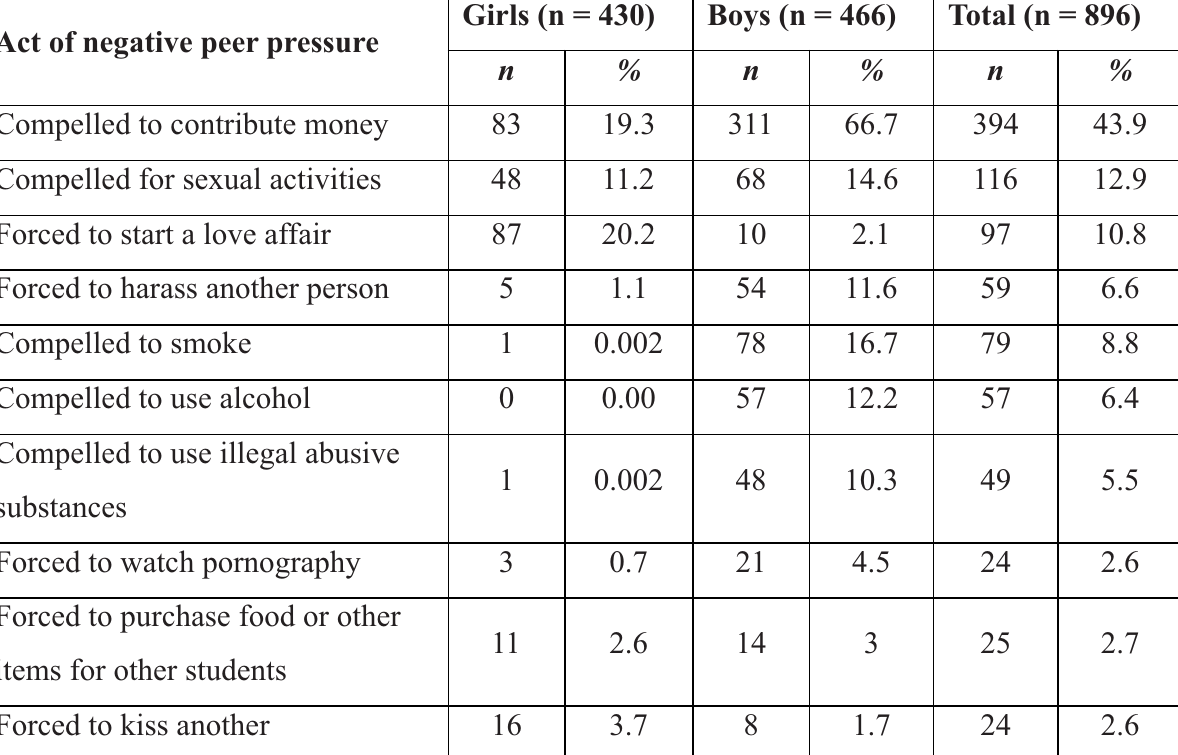
Table 2: Commonly reported acts of negative peer pressure according to